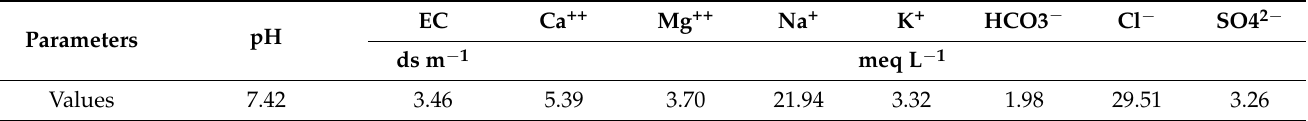
Table 10. Chemical properties of irrigation water used in this investigation.